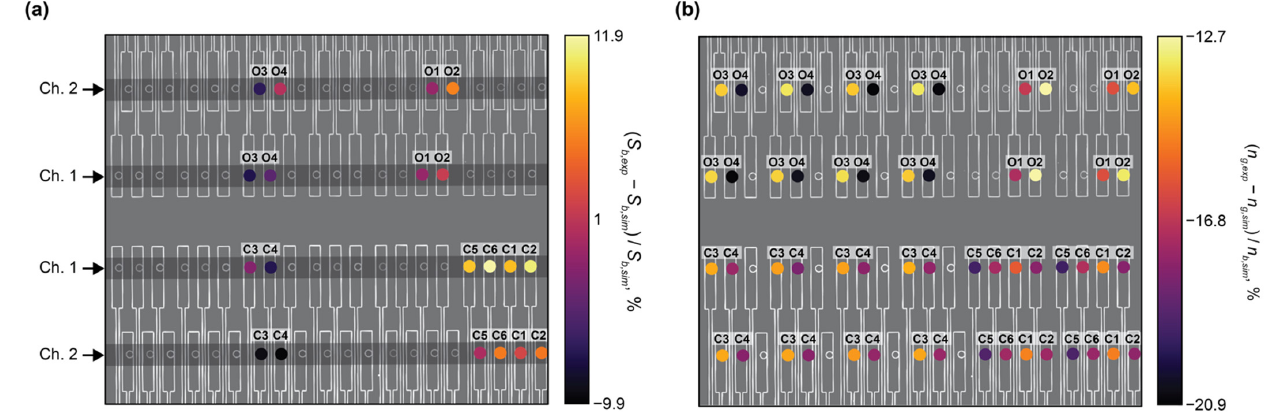
Figure 12. ( a ) Bright-field micrograph of the sensor chip (converted to grayscale) with markers indicating the locations of each ring resonator used for the bulk sensing measurements. The marker colors are mapped to the percent difference between the measured and simulated S b for each resonator. The positions of the two microfluidic channels for each set of testing (O-band and C-band) is denoted by darker gray rectangular overlays. ( b ) Bright-field micrograph of the sensor chip with markers indicating the locations of each ring resonator characterized in Section 3.1. The marker colors are mapped to the percent difference between the measured and simulated n g for each resonator.